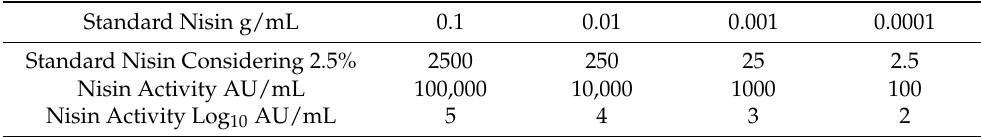
Table 1. Relation of concentration of standard nisin product, containing 2.5% of nisin, to its activity in AU and Log 10